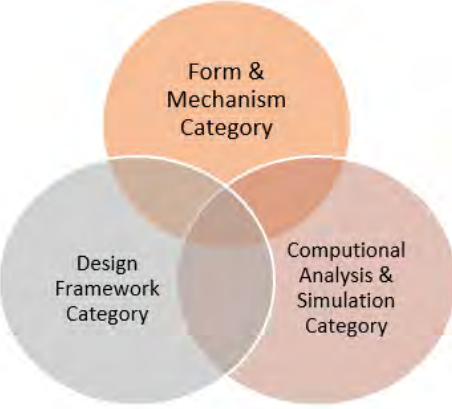
Figure 1. Categorization of different researches examining the daylight performance using kinetic systems (source: